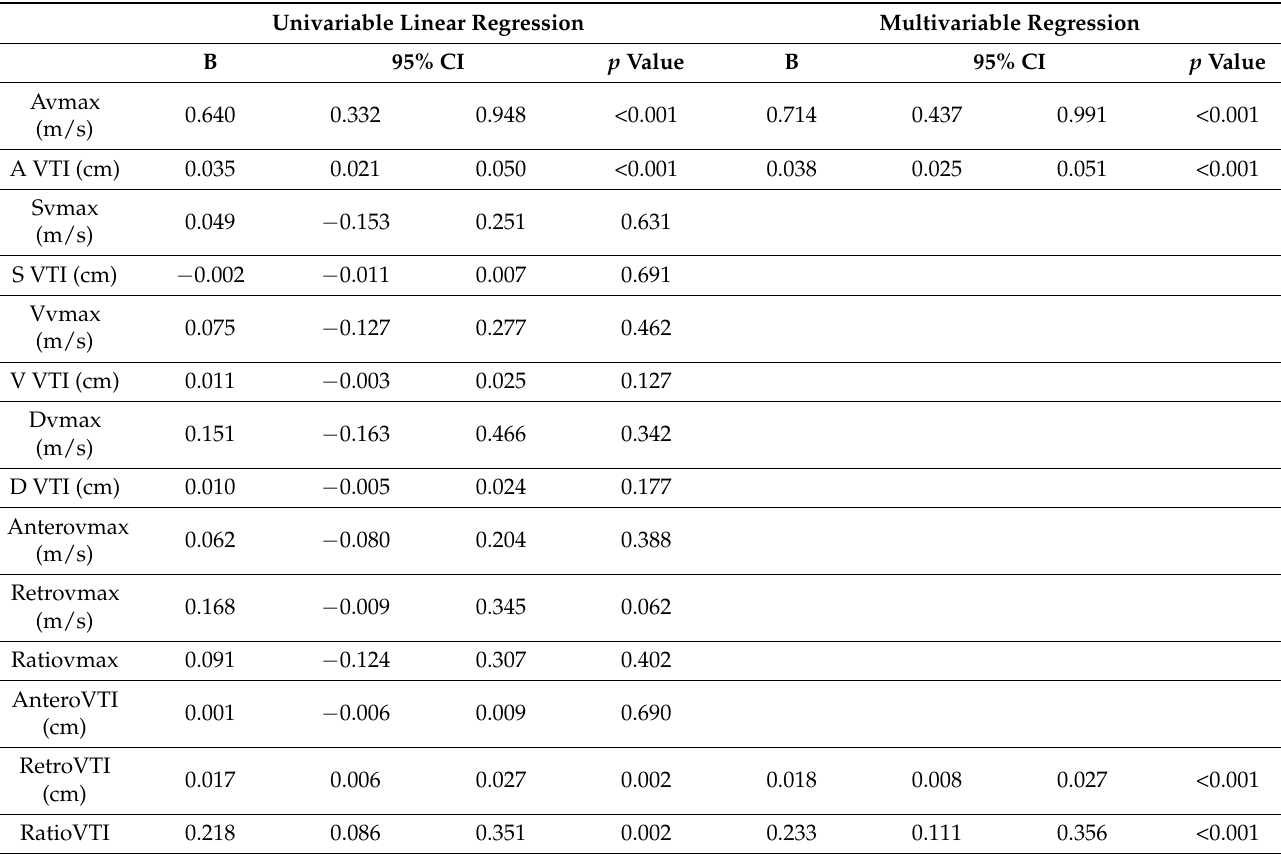
Table 2. Results of the regression models for postoperative creatinine change. Univariable Linear Regression Multivariable